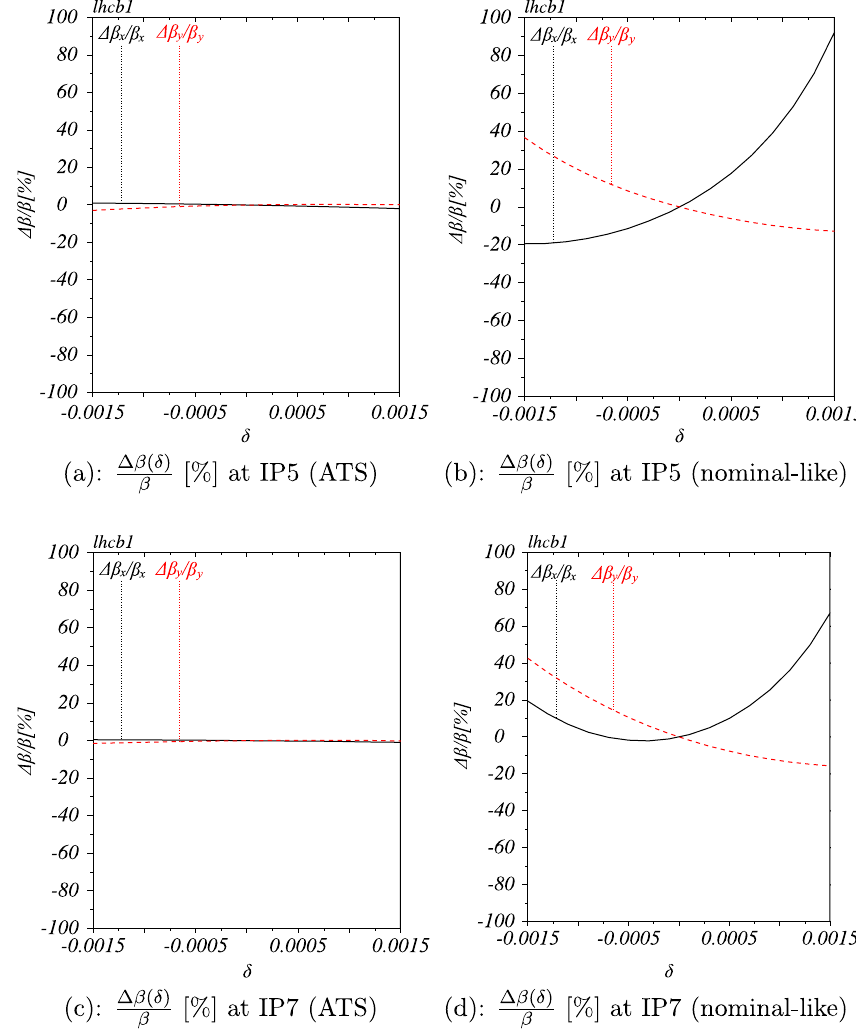
FIG. 7. Chromatic variations of the (cid:1) functions [%] at IP5 (top) and IP7 (bottom), shown on the left for an ATS optics presqueezed down to (cid:1) (cid:1) ¼ 36 cm at IP1 and IP5 (see case 2 of Table I), and compared to a nominal-like LHC collision optics with (cid:1) (cid:1) ¼ 35 cm (right